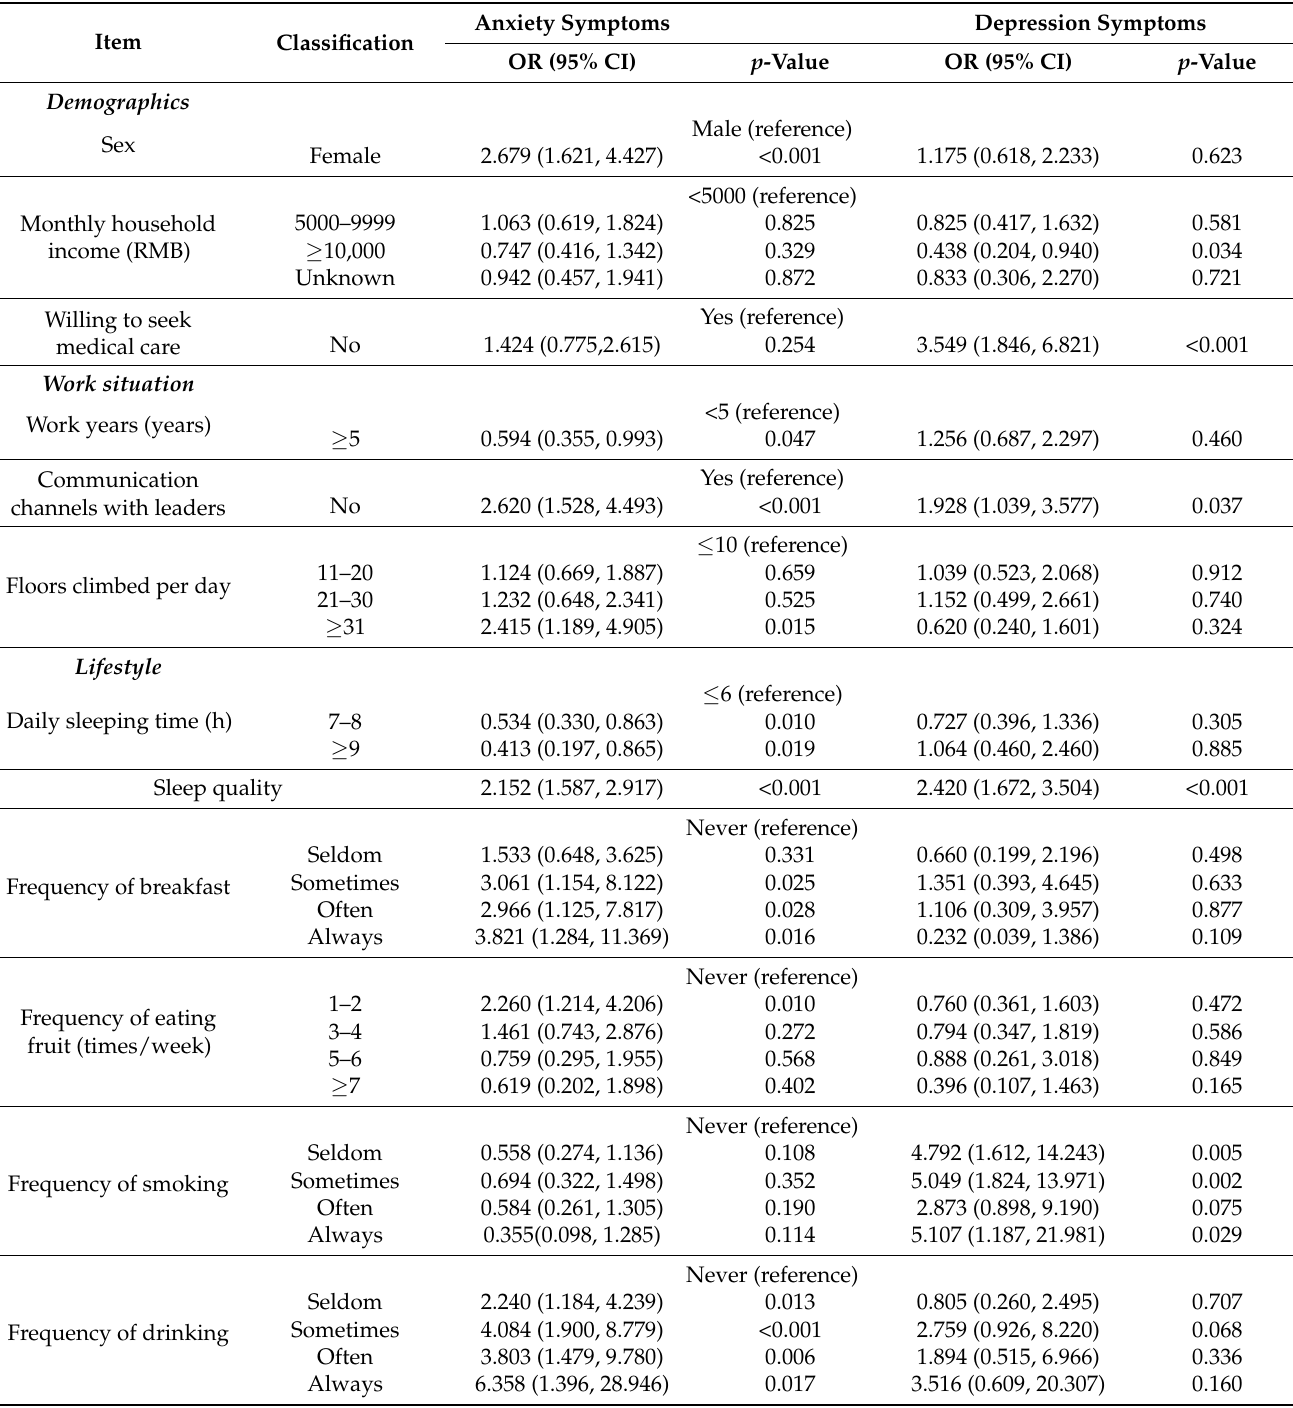
Table 3. Logistic regression of factors associated with anxiety and depression symptoms among food delivery